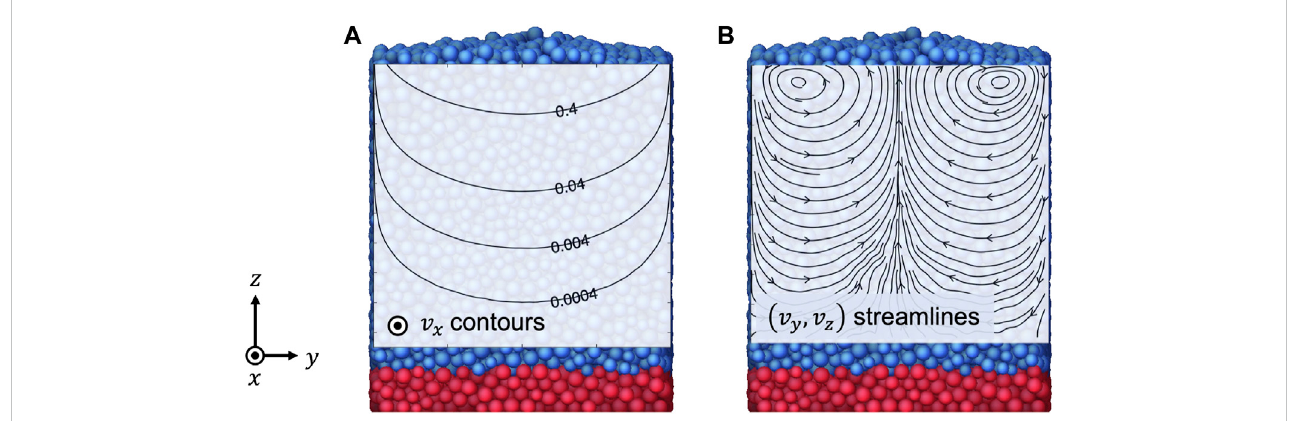
FIGURE 1 SnapshotfromDEMsimulationofgranular fl owinachutewithaninclinationangleoftan − 1 (0.50).Contourplotin (A) showsdownstreamvelocity v x which decreases exponentially with depth (creeping fl ow). The unit is velocity ( v y , v z ) which is small but not zero (secondary fl ow). Our goal is to build a second-order non-local model that can explain both fl ows. Details of the simulation can be found in Section